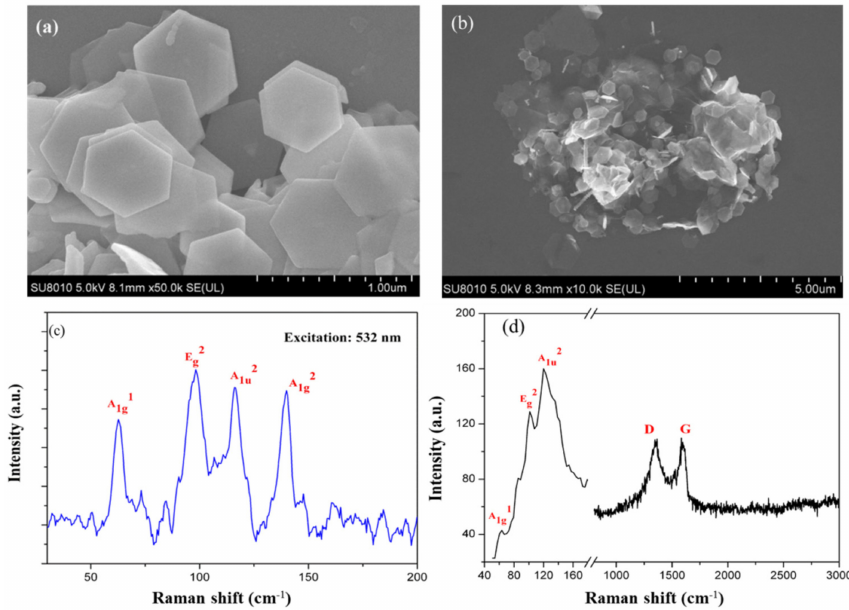
Figure 3. ( a ) SEM image of Bi 2 Te 3 ; ( b ) SEM image of the Bi 2 Te 3 /graphene heterostructure; ( c ) Raman spectrum of Bi 2 Te 3 ; ( d ) Raman spectrum of the Bi 2 Te 3 /graphene